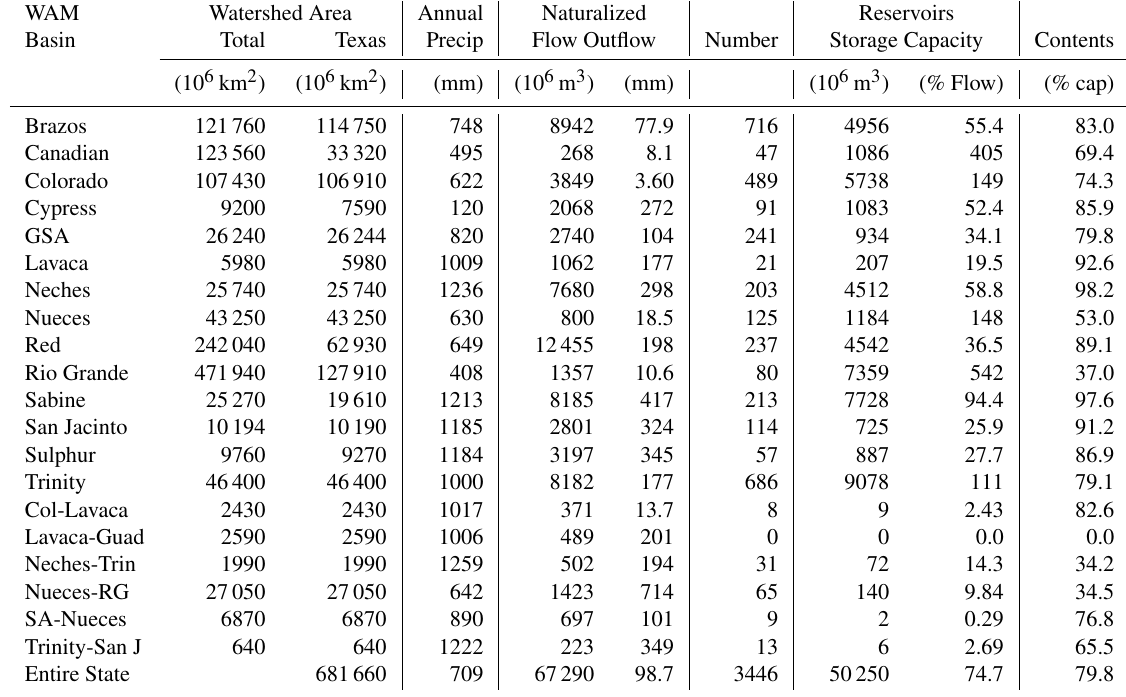
Table 3. River basin